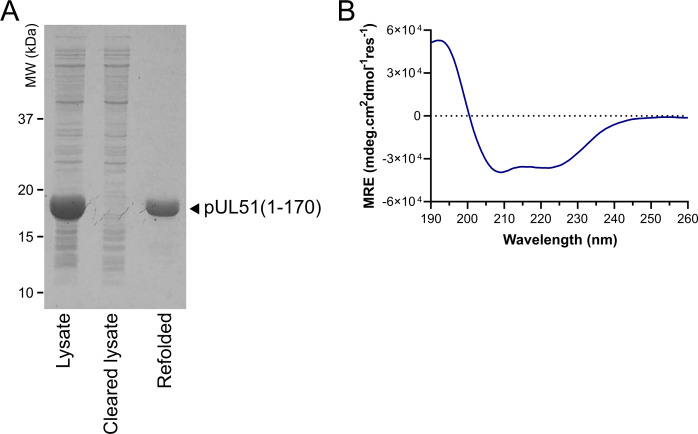
Purification of His-tagged pUL51(1-170).(A) Coomassie-stained SDS-PAGE analysis of His-pUL51(1–170) purification from inclusion bodies, showing depletion of insoluble pUL51 from the bacterial cell lysate by centrifugation and the purified sample after refolding. (B) Circular dichroism spectrum of His-pUL51(1–170). The spectrum is consistent with the pUL51 N-terminal region having a predominantly α-helical composition, as expected from the crystal structure and secondary structure predictions (Figure 2; Figure 1—figure supplement 2). Decomposition of the spectrum using CDSSTR (as implemented by DichroWeb) gives an overall helical fraction of 0.8 (0.6 regular α-helix, 0.2 distorted α-helix) with a normalized root-mean-square deviation of 0.002 over 177 residues. MRE, mean residue ellipticity.